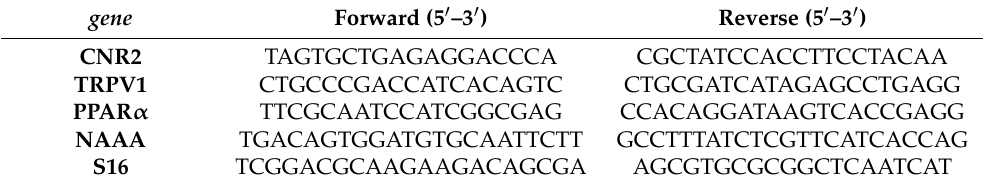
Table 1. List of primer sequences used in the qPCR